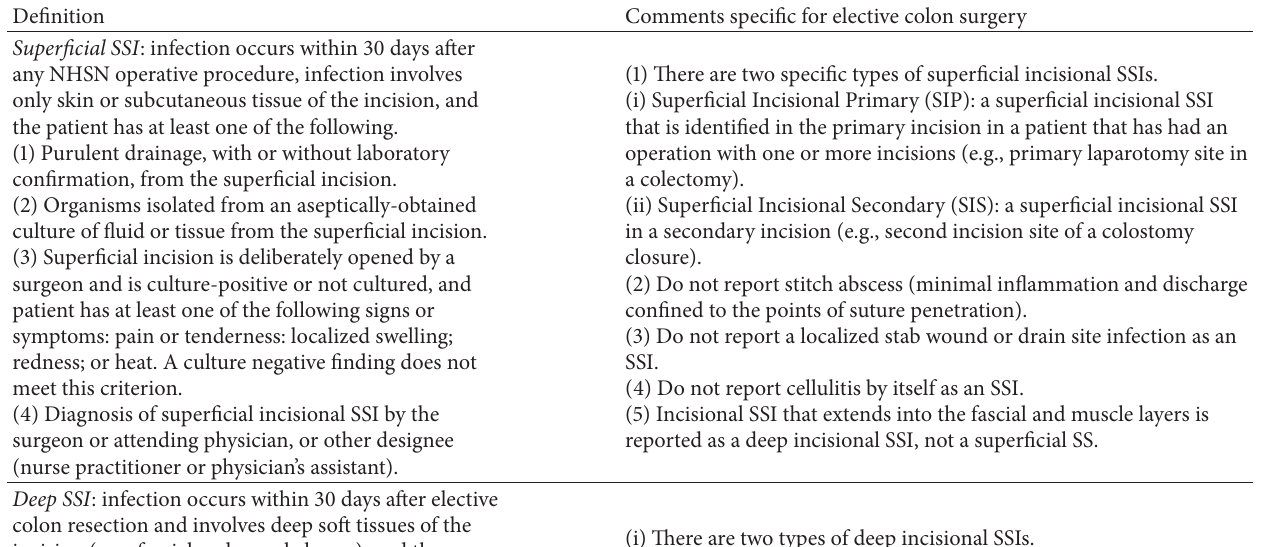
Table 1: Definitions of superficial, deep, and organ/space SSIs as defined by the National Healthcare Safety Network. The comments are specifically applied to elective colon